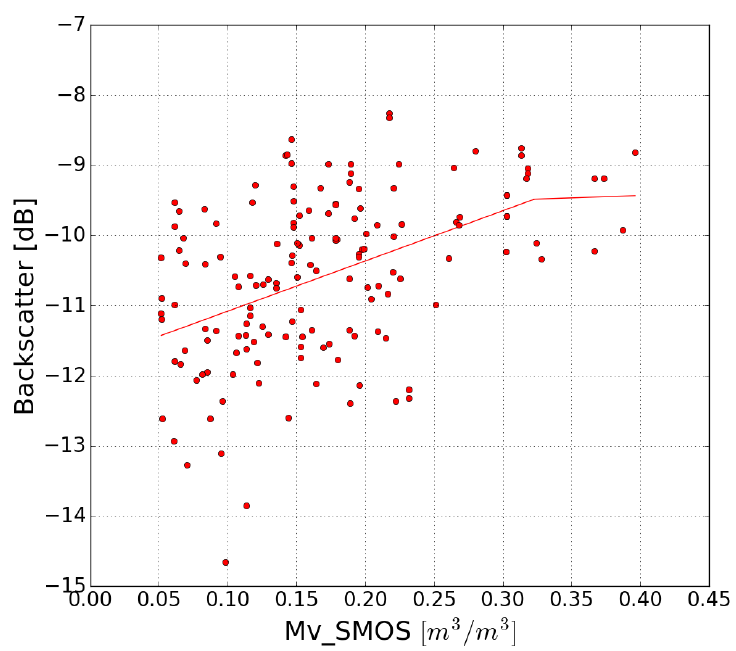
Figure 5. Mean S1 radar signal as a function of the SMOS soil moisture computed over a single SMOS pixel (40 km × 40 km). The radar signal saturates beyond soil moisture levels of 0.32 m 3 /m 3 .